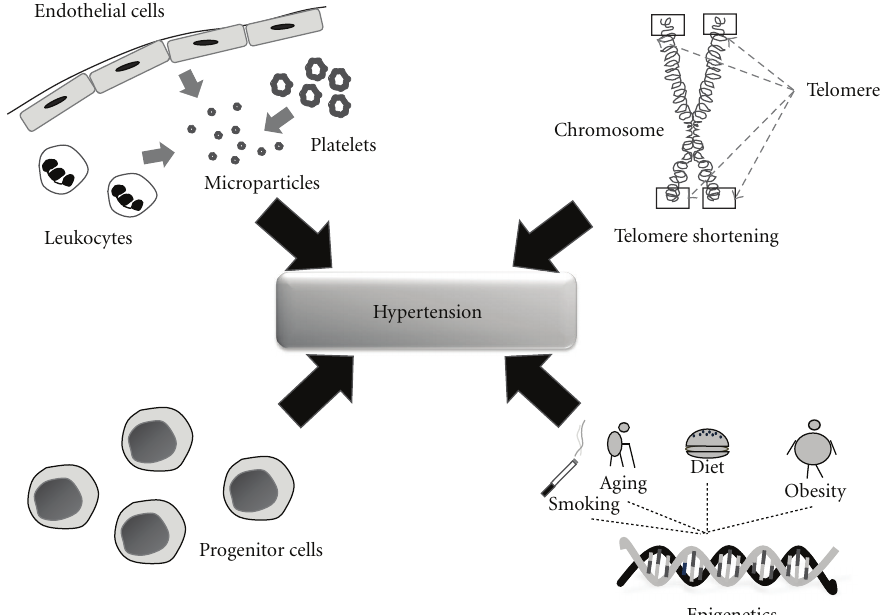
Figure 2: New mechanisms involved in hypertension in the elderly population. Telomere shortening, dysfunction of progenitor cells, increase of platelet, leukocyte, erythrocyte, and endothelial cells-derived microparticles, and epigenetic alterations together with the involvement of life style are proposed as new mechanisms associated with